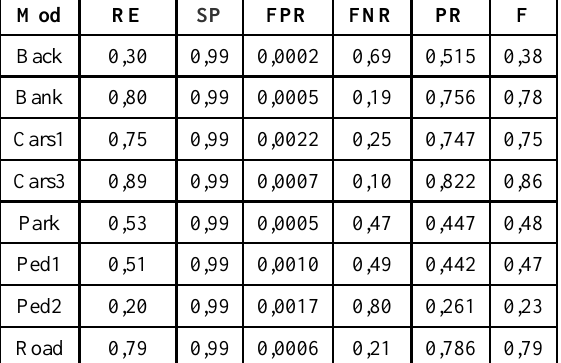
Figure 5. Experimental results for video Cars1. Top row: left – current frame, right – ground truth. Bottom row: left – original algorithm, right – our modified